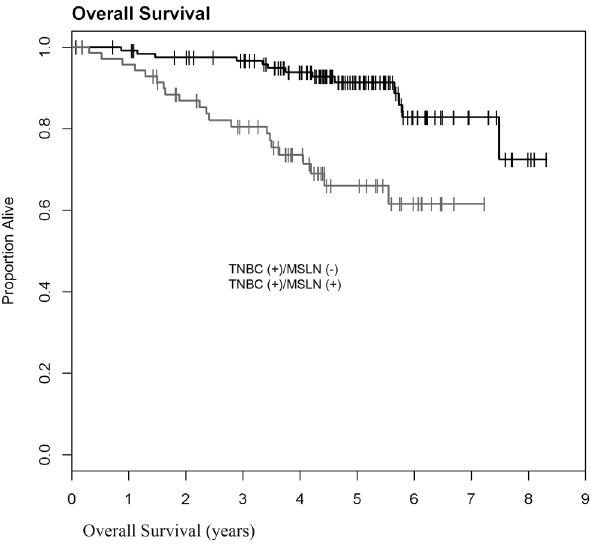
Fig. 3. MSLN expression in TNBC correlates with significantly decreased overall survival (p , 0.0001, n 5 198).